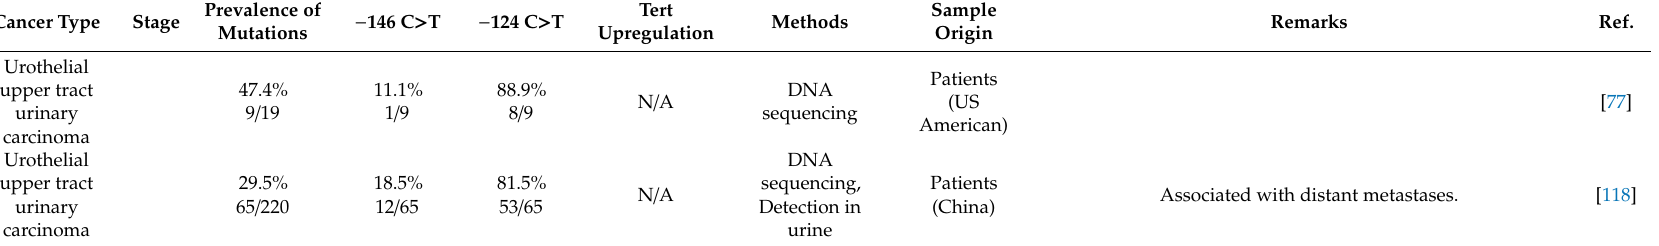
Patients (China) Patients (Sweden) Patients (Korea) Patients Patients (Korea) Patients (US & Japan) Patients